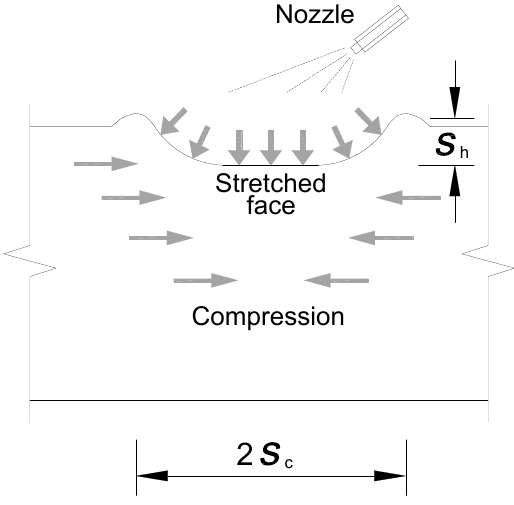
Figure 6. Height and width in a unit valley in roughness profile.